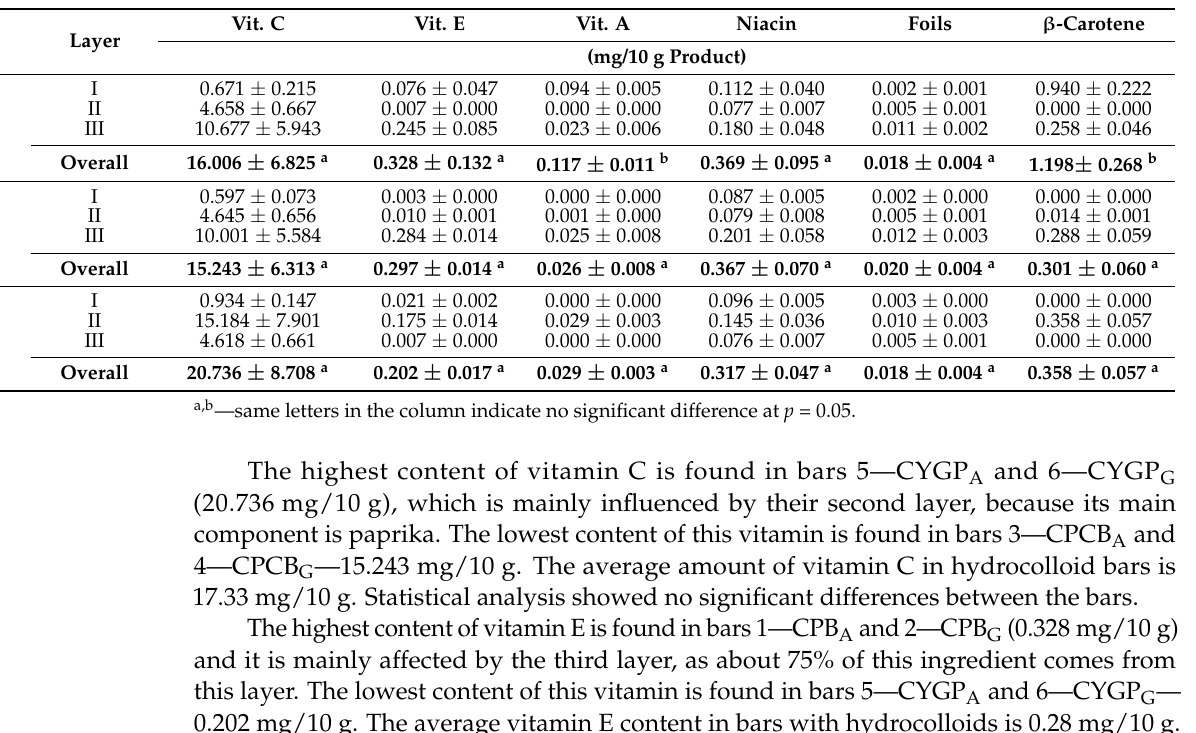
Table 2. Average content of selected vitamins (pro-health value) in freeze-dried products formed on the basis of vegetables produced with